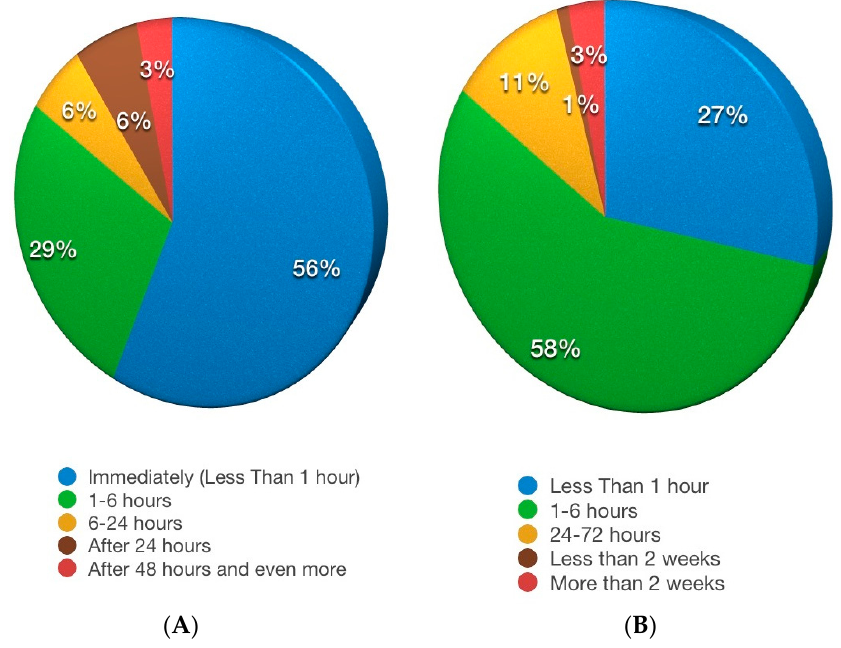
Figure 2. ( A ) Time lapse between wheat ingestion and symptom appearance in self-reported NCWS subjects; ( B ) Duration of the symptoms after wheat ingestion in subjects with self-reported NCWS.